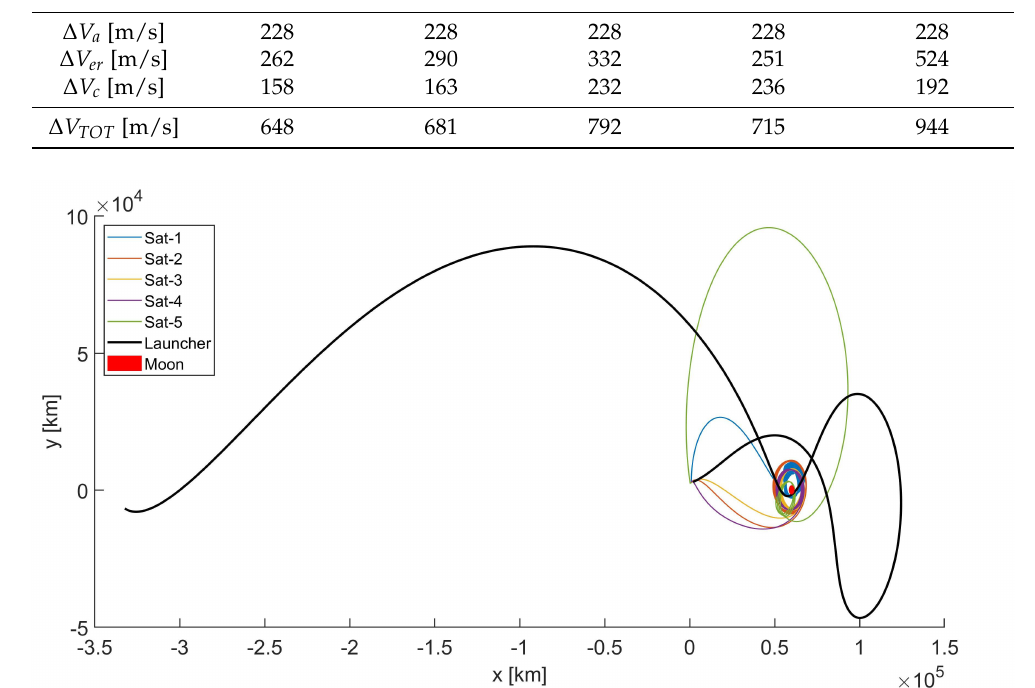
Figure 2. Satellite trajectories during Phase 2: projection onto the [ ˆ x , ˆ y ] plane.